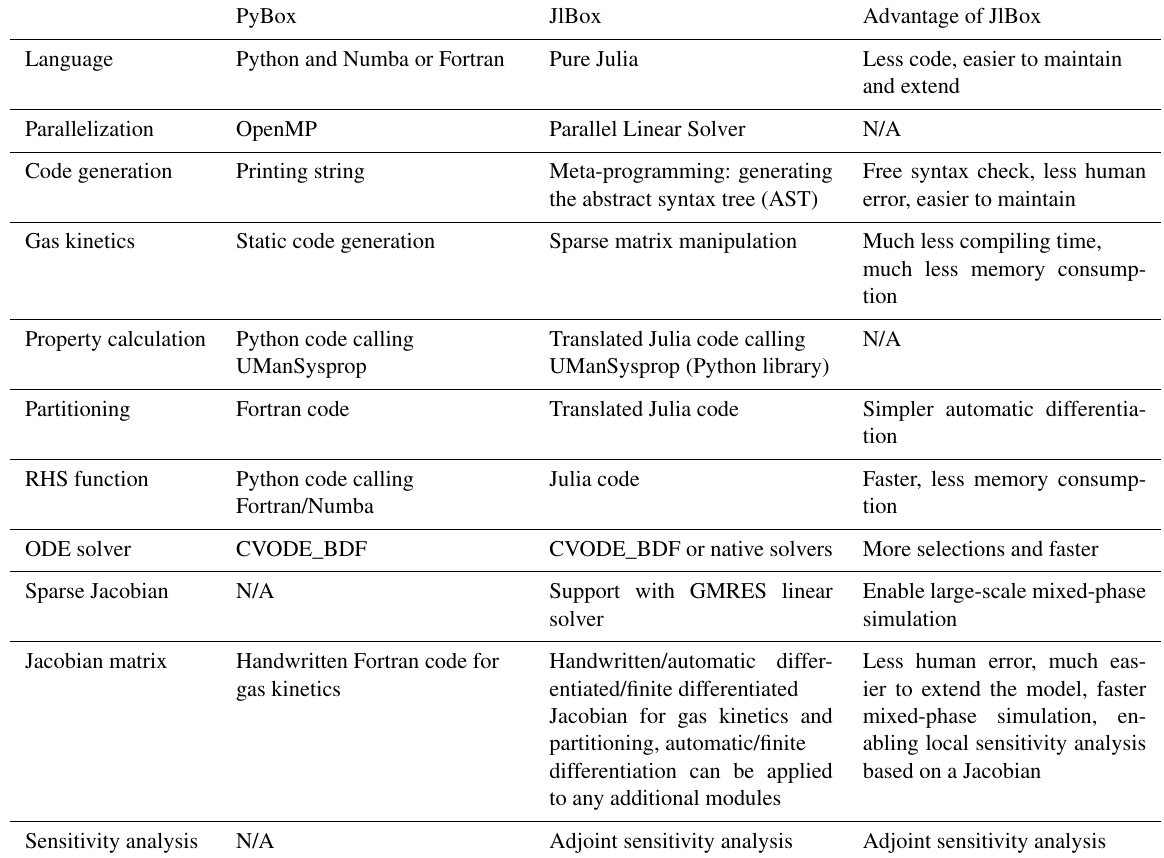
the abstract syntax tree